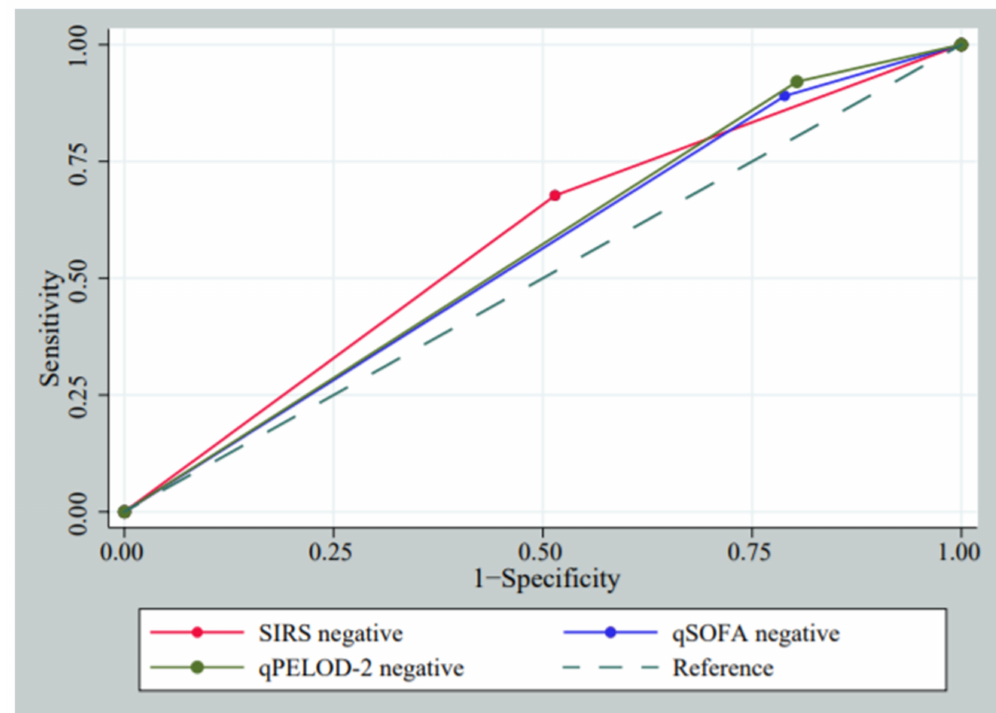
Figure 2. ROC curves of negative (<2 scores) SIRS, qSOFA, and qPELOD-2 criteria for predicting no antibiotic therapy at ICU. ICU, Intensive Care Unit; SIRS, Systemic Inflammatory Response Syndrome; qSOFA, quick Sequential Organ Failure Assessment; qPELOD-2, quick Pediatric Logistic Organ Dysfunction score-2; ROC, Receiver Operating Characteristic curve.